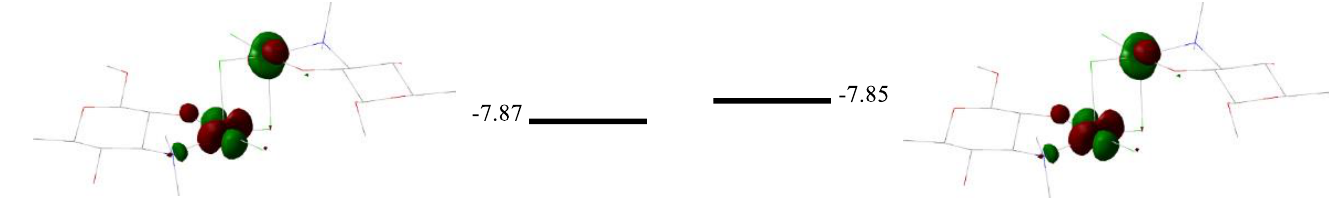
Figure 13. Energy (in eV) and plots of SOMO_1 ( left ) and SOMO_2 ( right ) of the green dinuclear micaminosyl species 7 ( BHandHLYP ).